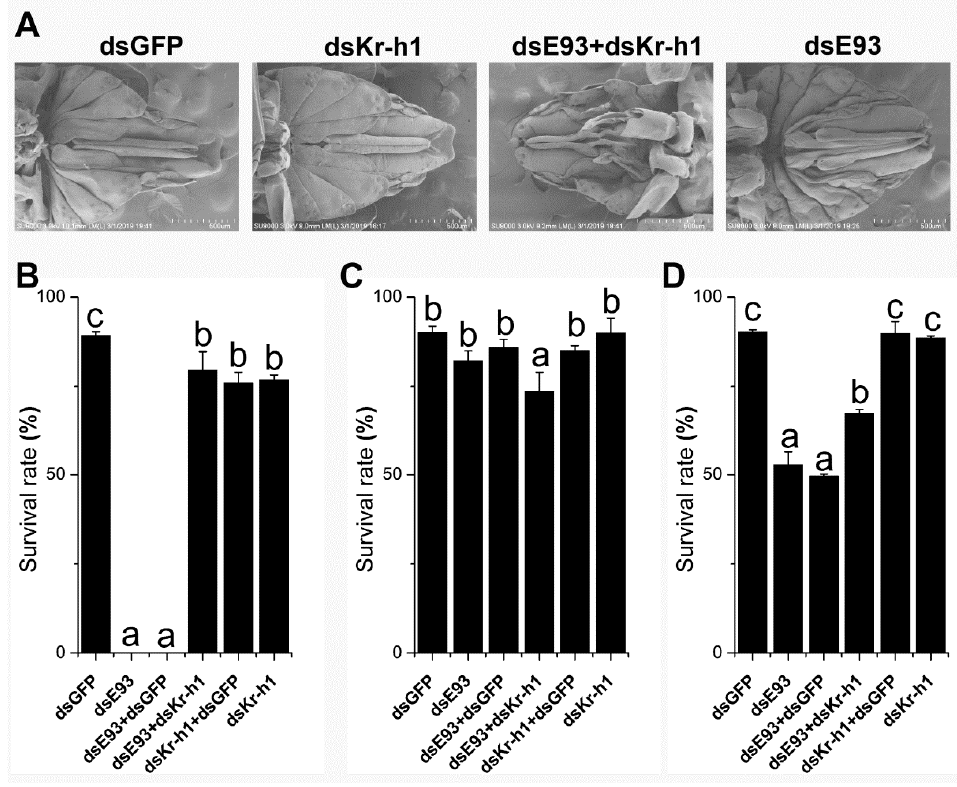
Figure 1. Downregulation of Kr-h1 partially recovered the deteriorating effect of E93 knock-down on metamorphosis. ( A ) External genitalia phenotype of brown planthoppers after RNAi of E93 and Kr-h1 alone or together . Transmission electron microscopy (TEM) was used to observe the phenotype of external genitalia after the eclosion of adults. Nymphs were injected at the 4th instar stage. ( B ) dsRNAs of E93 and Kr-h1 were injected alone or together at the 3rd instar larval stage, and the survival rate after moulting from the 3rd to 4th instar nymph stage is shown; ( C ) dsRNA of E93 and Kr-h1 were injected alone or together at the 4th instar nymph stage, survival rate after moulting from 4th instar nymph to 5th instar nymph is shown; ( D ) survival rate after metamorphosis from the 5th instar nymph to adult after the injection of E93 and Kr-h1 alone or together. Duncan’s multiple comparison was used, and different letters indicate significant differences ( p < 0.05).